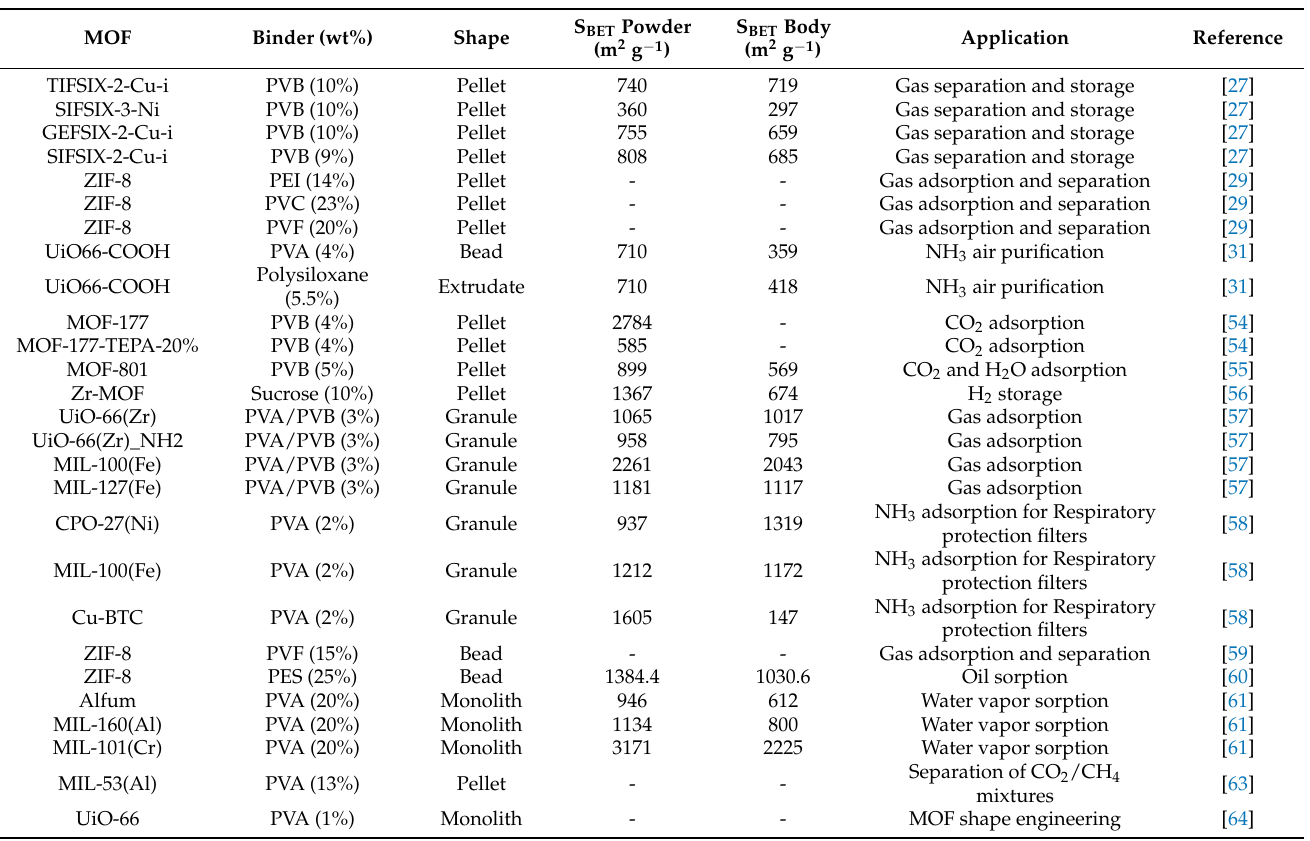
Table 1. Summary of shaped MOFs with organic